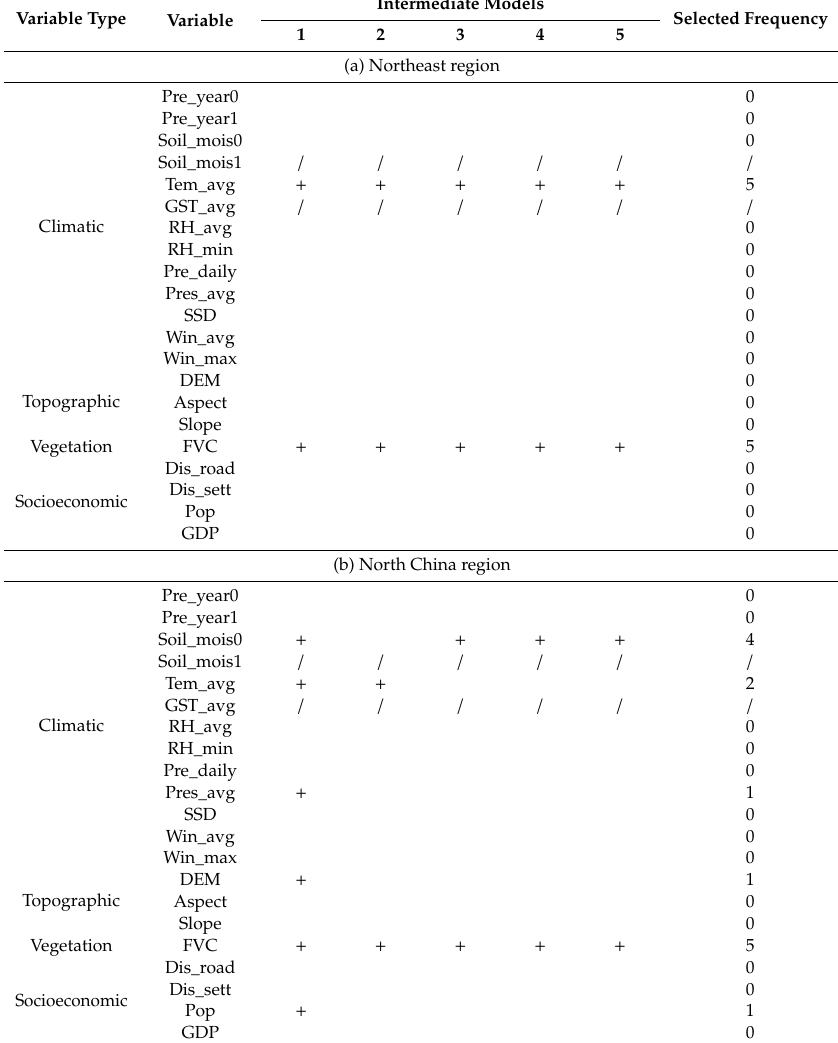
Table A1. The results when identifying the significant variables in each intermediate model in six geographical regions and the whole study